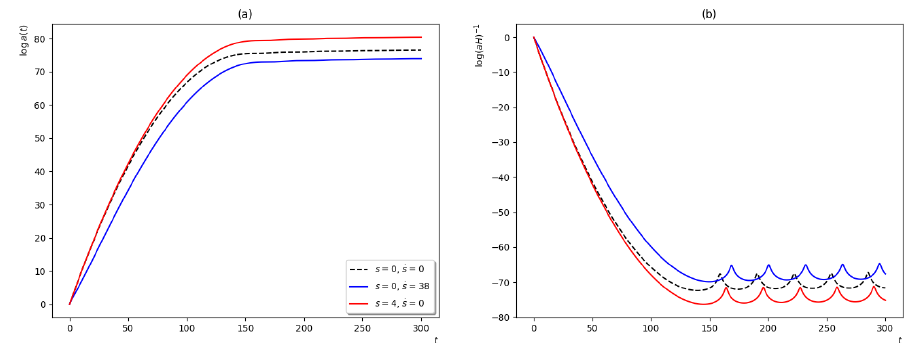
Figure 2. Numerical solutions to Equation (37). The initial conditions for the scale factor are the same as in Figure 1. Here, we have an additional scalar field. ( a ) Scale factor. ( b ) Comoving Hubble length for pure kinetic initial energy (blue color) and pure potential initial energy (red color) of the field s . The dotted line is the same as in the pure Starobinky dynamics of Figure